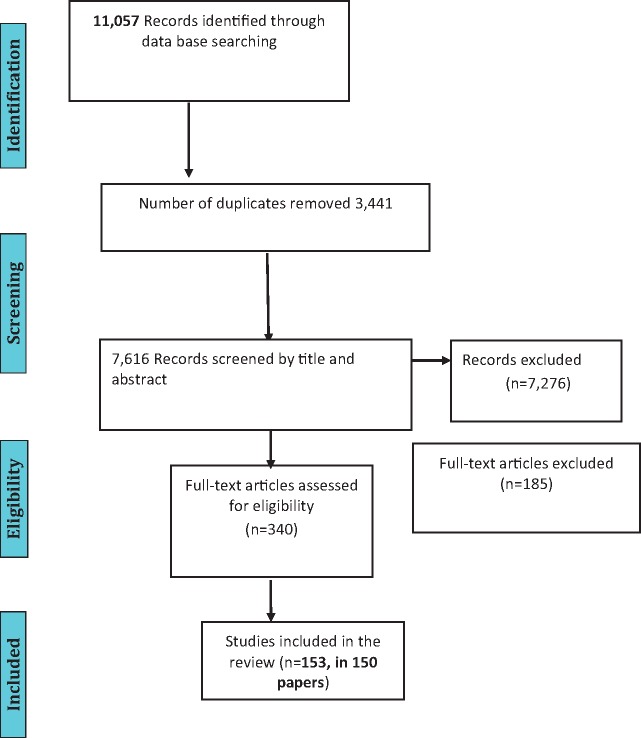
Study flow diagram.